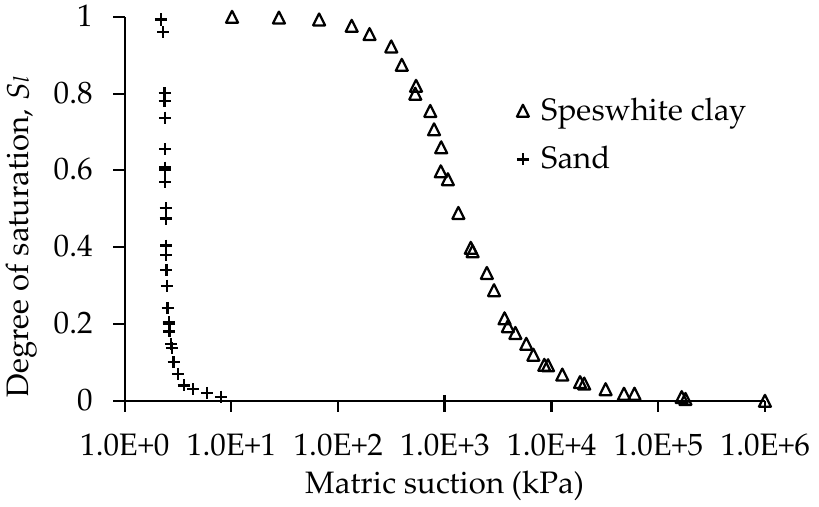
Figure 4. Soil-water characteristic curves (SWCC) for sand, and clay (after Singh (2007)).